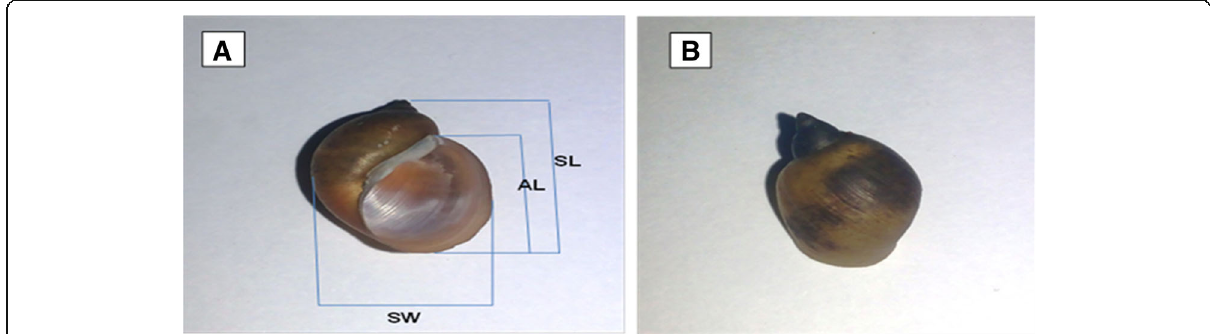
Fig. 3 Shell dimensions of L . natalensis snails. a Ventral view. b Dorsal view. AL aperture length, SL shell length, SW shell width